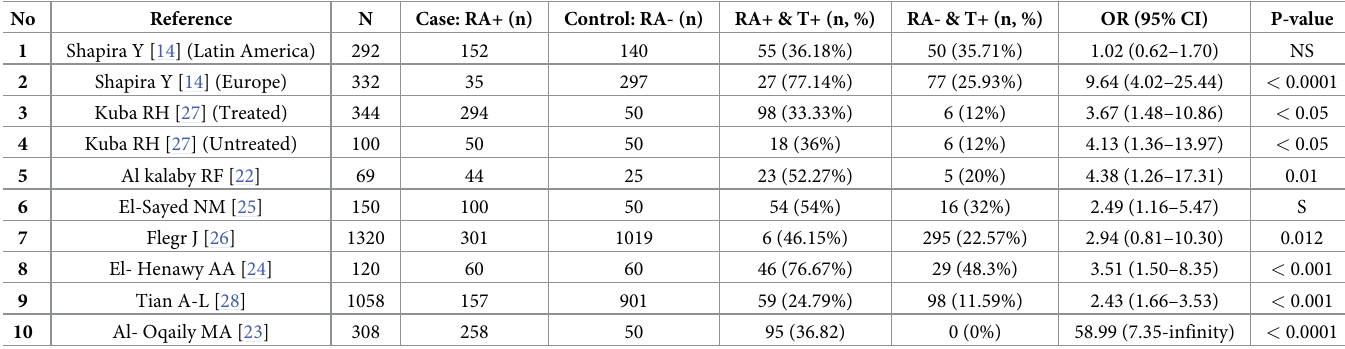
Table 2. Data extracted from the included studies in the meta-analysis for an association between toxoplasmosis and